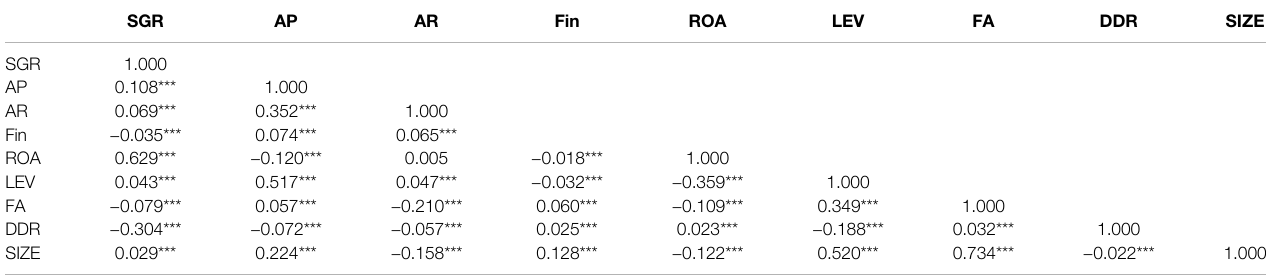
TABLE 3 | Correlation matrix.